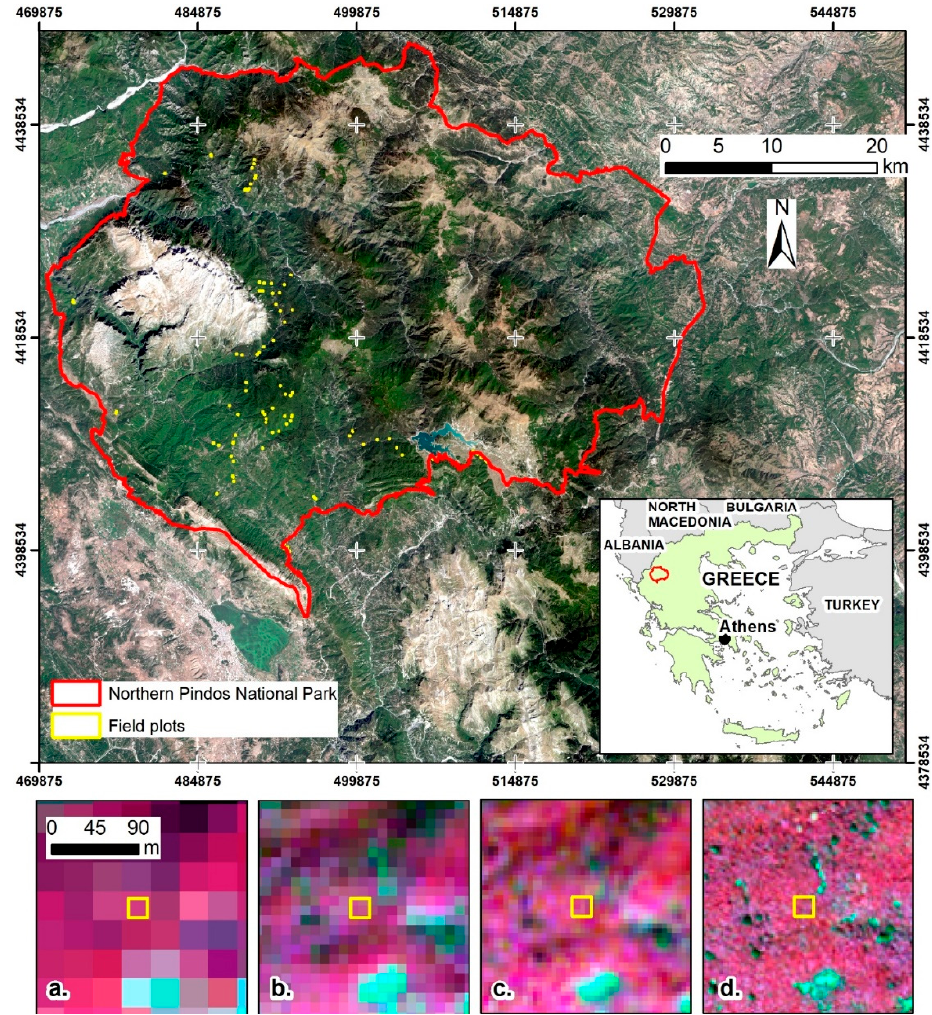
Figure 1. Extent of the study area and 100 field plots’ location. In the lower row, subsets of the Landsat-8 Operational Land Imager (OLI) ( a ), Sentinel-2 Multispectral Instrument (MSI) ( b ), RapidEye ( c ), and WorldView-2 ( d ) satellite sensors used in illustrating the spatial resolution differences (R: NearInfared, G: Red, Blue: Green) are shown.